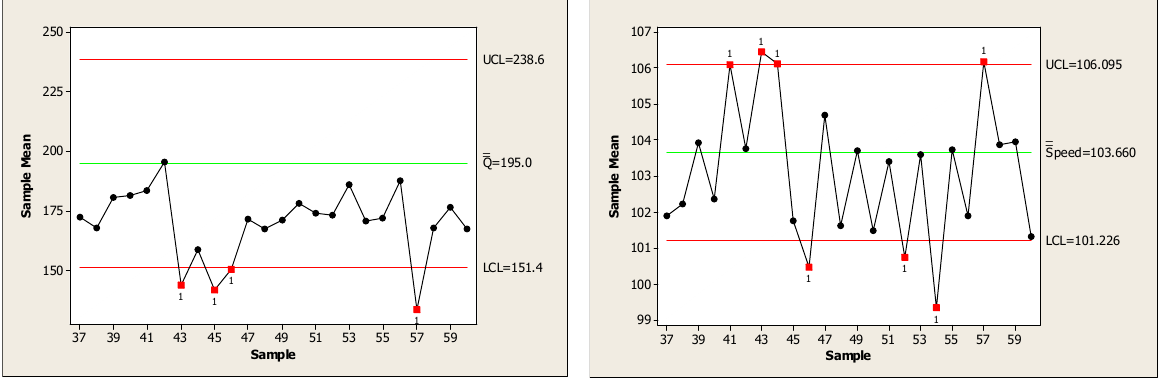
Fig. 7. Flow Control Chart in Phase 2 Fig. 8. Speed Control Chart in Phase